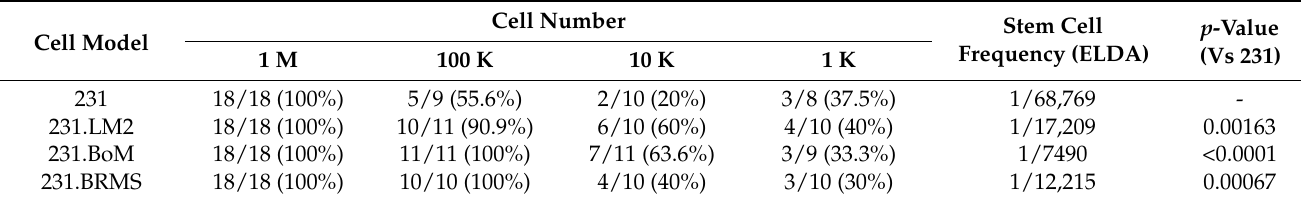
Figure 3. In vivo limiting dilution assay (LDA) workflow: a timeline of the chorioallantoic membrane (CAM) and mice experiments. Fertilized eggs are incubated for 3 days; at which time, a window in the shell is opened. At embryonic development day 9 (EDD9), breast cancer cells are inoculated on top of the CAM. At EDD16, eggs are sacrificed, and the tumor growth is examined. Mice with 6–8 weeks of age are subcutaneously injected with breast cancer cells. Tumor growth is monitored for 3 weeks. At weeks 9–11, mice are sacrificed and tumors are further examined. Table 1. Stem cell frequency in chorioallantoic membrane (CAM) tumors. Limiting dilution data as the percentage of tumor-forming eggs. The frequency of cancer stem cells (CSCs) was estimated using the Extreme Limiting Dilution Analysis (ELDA) calculating website. Confidence choice entered was 0.95, and p -values reflect differences in CSC frequencies between the metastatic cell lines (231.LM2, 231.BoM and 231.BRMS) and the parental cell line (231). N per group varied between 8–18 eggs for a total of 191 eggs inoculated.